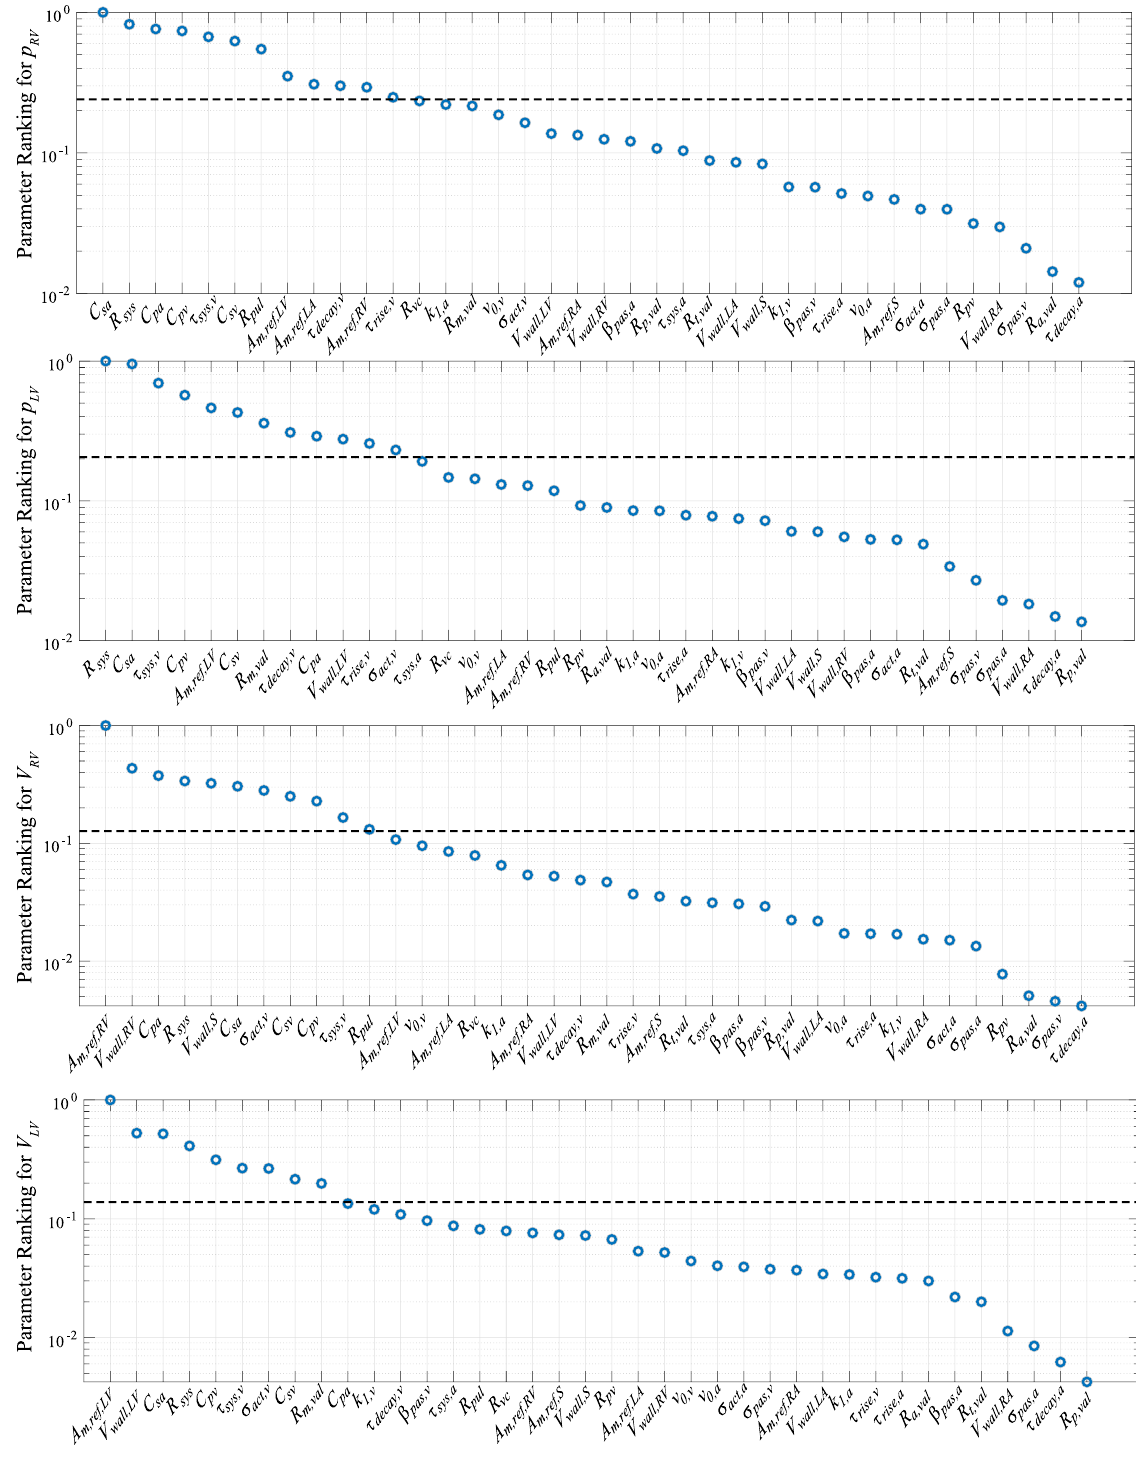
q ffiffiffiffiffiffiffiffiffiffiffiffiffiffiffiffiffiffiffiffi . The dotted ¼ m � 2 þ s 2 i ; f i ; f i ; f